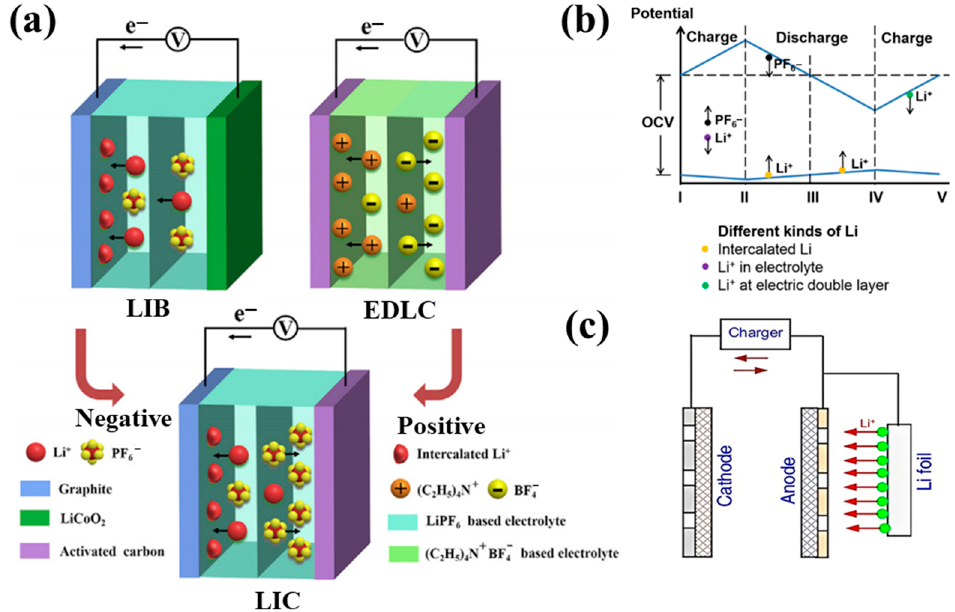
Figure 4. ( a ) Comparison of the working principles of the LIC with the LIB and EDLC, reproduced with permission from [11]. Copyright 2020, Elsevier.( b ) Charge transfer profiles of the positive electrode (AC) and negative electrode (pre − lithiated hard carbon) of the LIC, reproduced with permission from [74]. Copyright 2016, American Chemical Society. ( c ) Illustration of the pre-lithiation process, reproduced with permission from [76]. Copyright 2021, IOP Publishing.